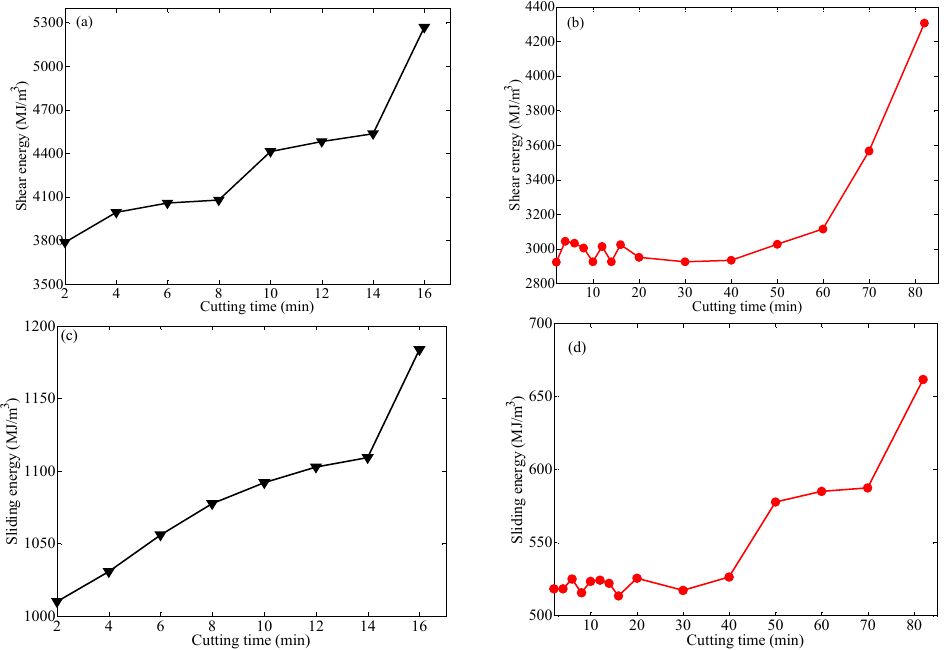
Figure 11. ( a ) Changes in Tool A shear energy with time. ( b ) Changes in Tool B shear energy with time. ( c ) Changes in Tool A sliding energy varies with time. ( d ) Changes in Tool A sliding energy with time.